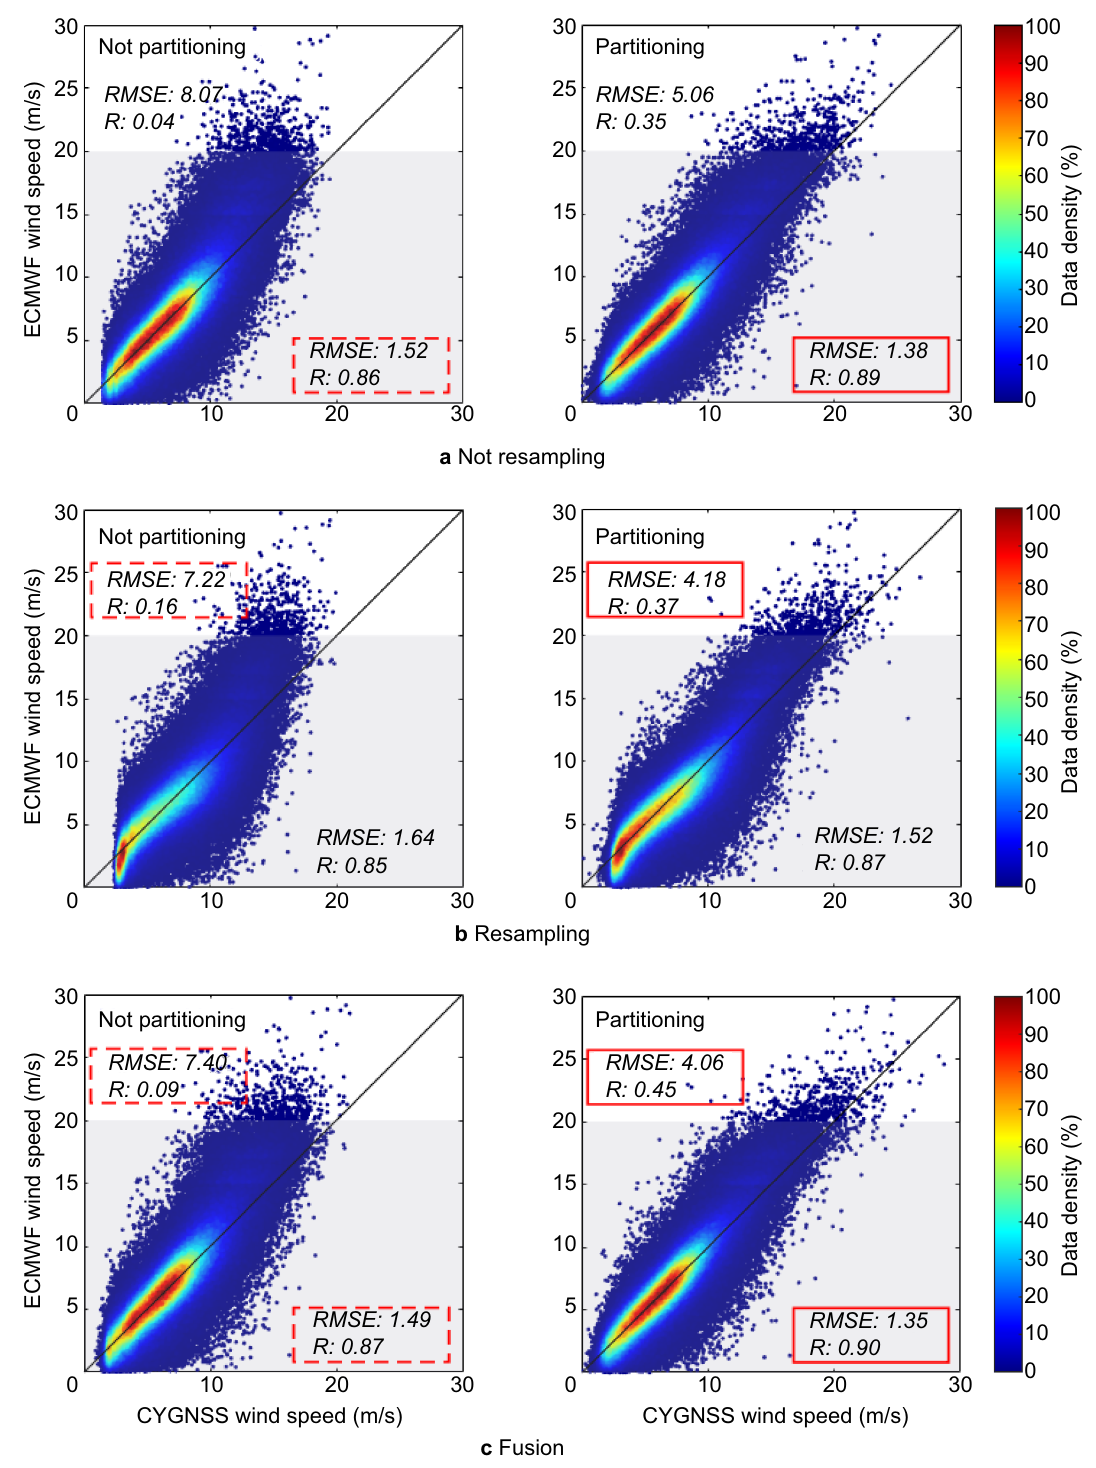
Fig. 9 Density scatterplots of ECMWF wind speed versus retrieved wind